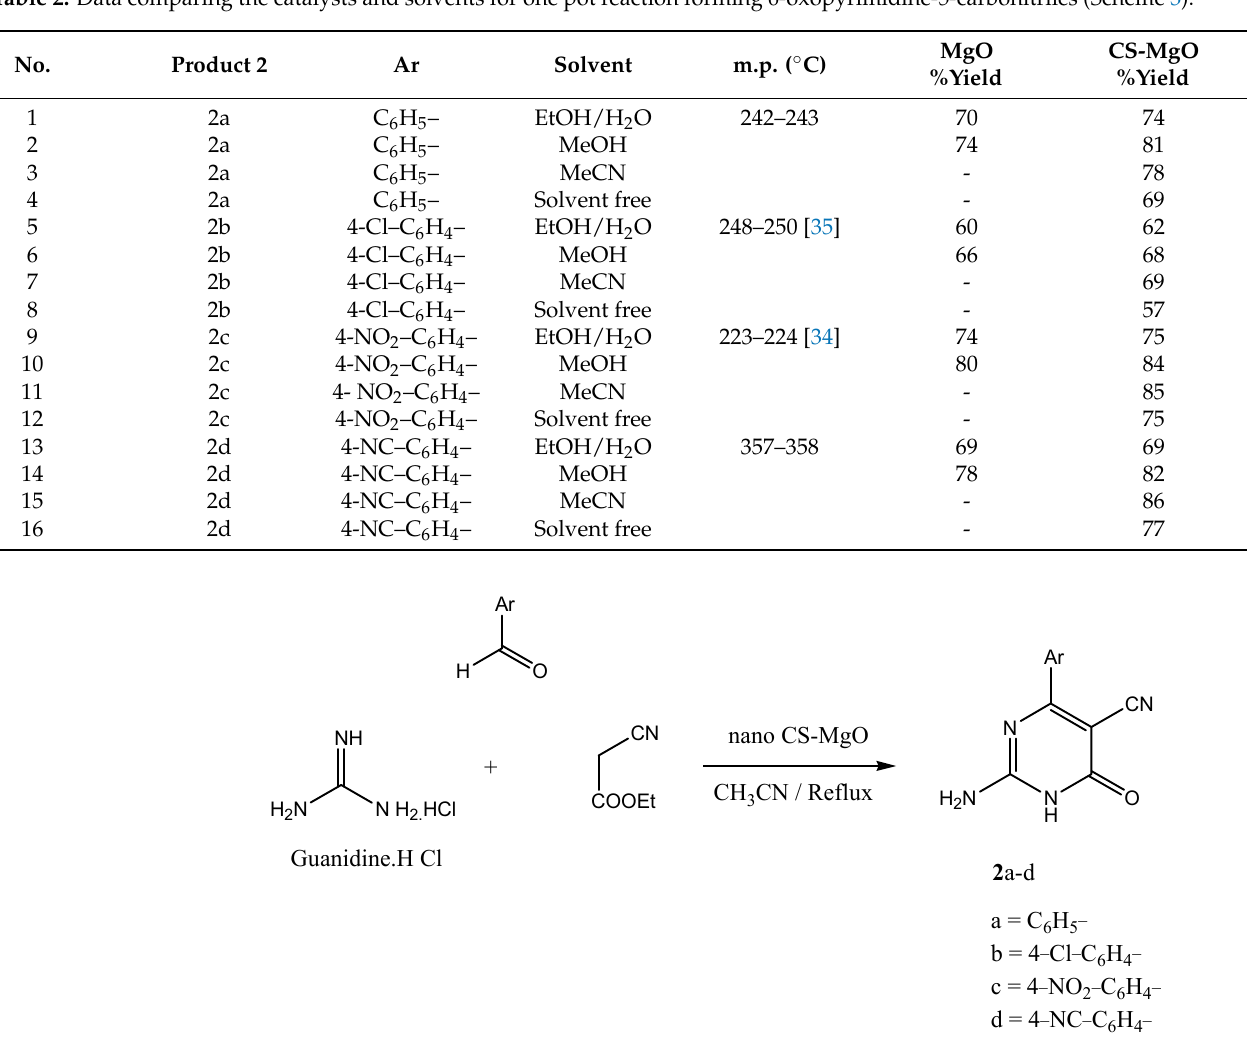
Scheme 3. CS-MgO (10 wt.%) catalyzed reaction forming Table 2. Data comparing the catalysts and solvents for one pot reaction forming 6-oxopyrimidine-5-carbonitriles (Scheme 3). No.